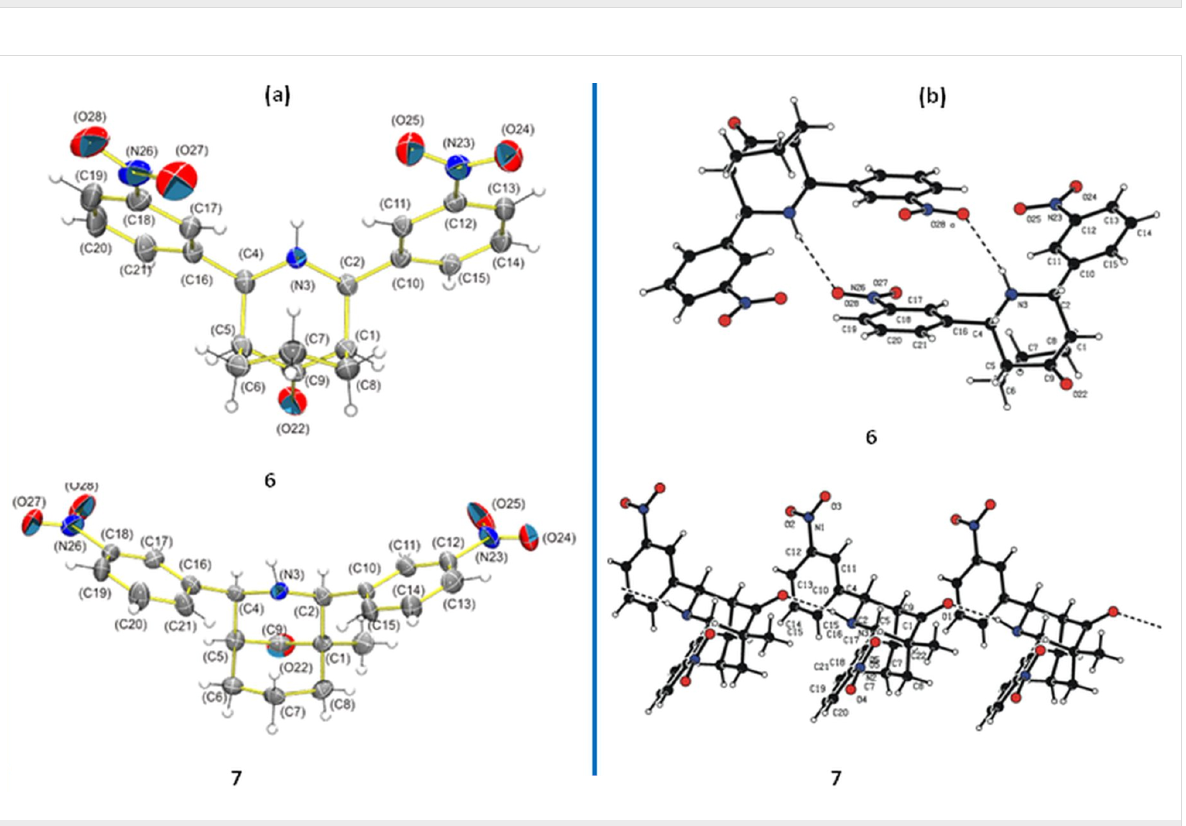
Figure 8: (a) ORTEP diagrams of 6 and 7 . The thermal ellipsoids are drawn at the 30% probability level for all atoms other than H. (b) N(3)–H(3) ∙∙∙ O(28) intermolecular hydrogen bonds of 6 and N(3)–H(3) ∙∙∙ O(22) intermolecular hydrogen bonds of 7 .